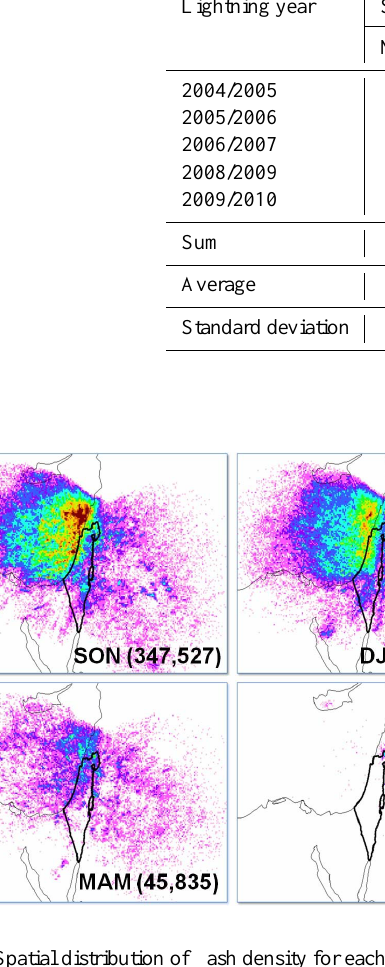
Fig. 5. Spatial distribution of flash density for each season in terms of the number of flashes/25km 2 per year, using a cell size of 5km 2 . The decrease in the number of flashes to the far west and east is associated with the system’s inability to monitor flashes that occur at a great